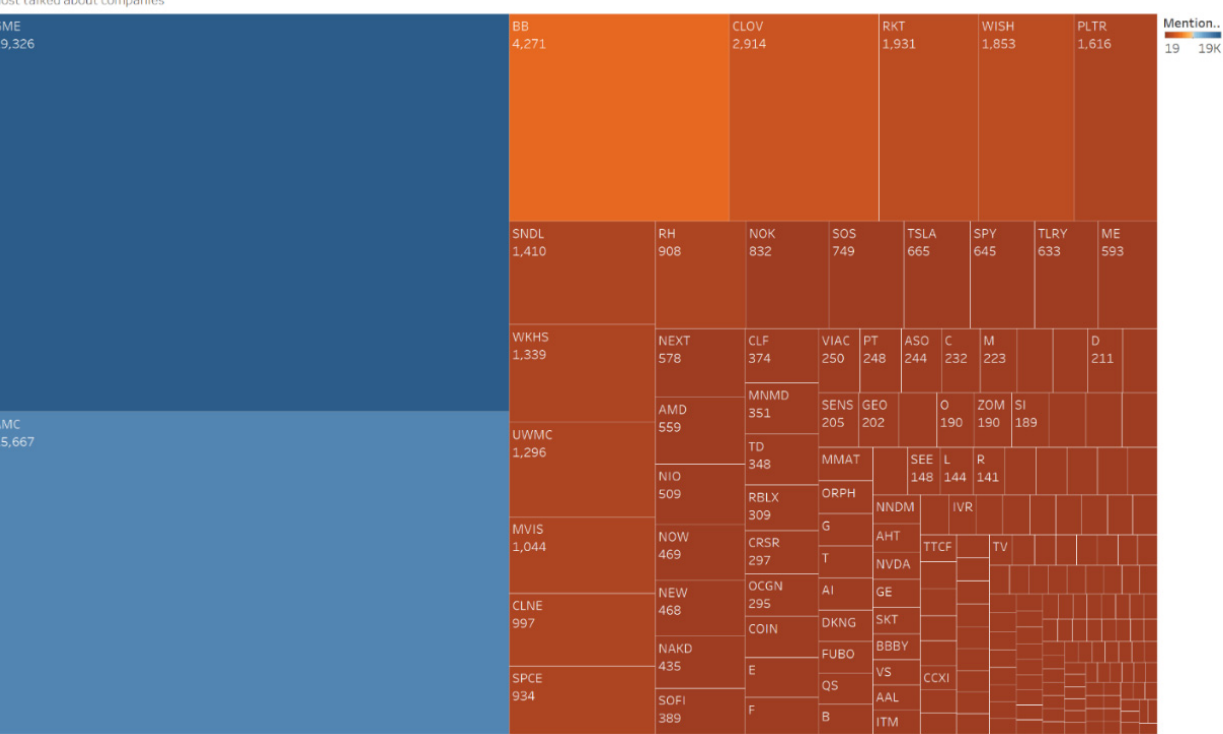
Figure 3. Tree map of the most mentioned stocks.